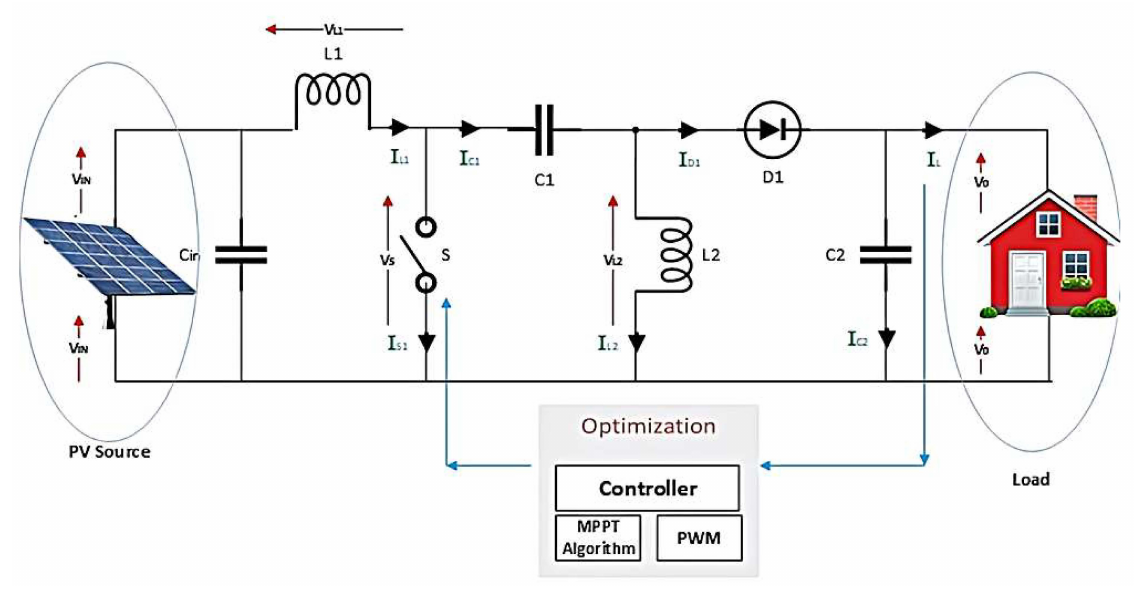
Figure 1. DC-DC cuk